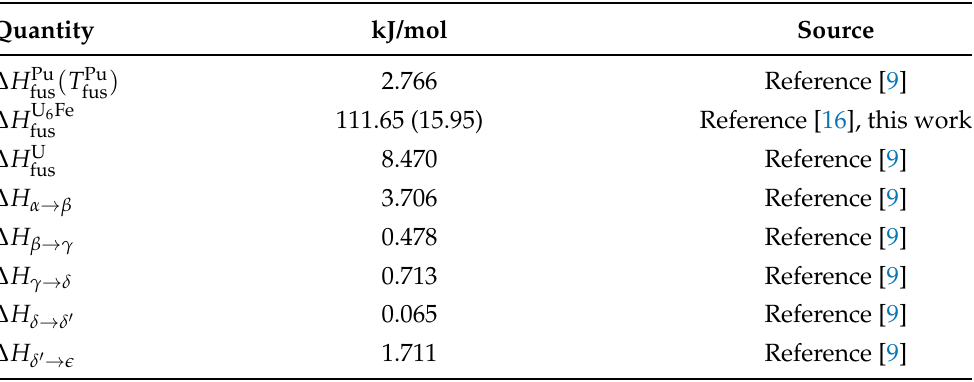
Table 3. Transition enthalpies used in the reanalysis of Pu 6 Fe melt data. Quantity in parenthesis is in kJ/(mol